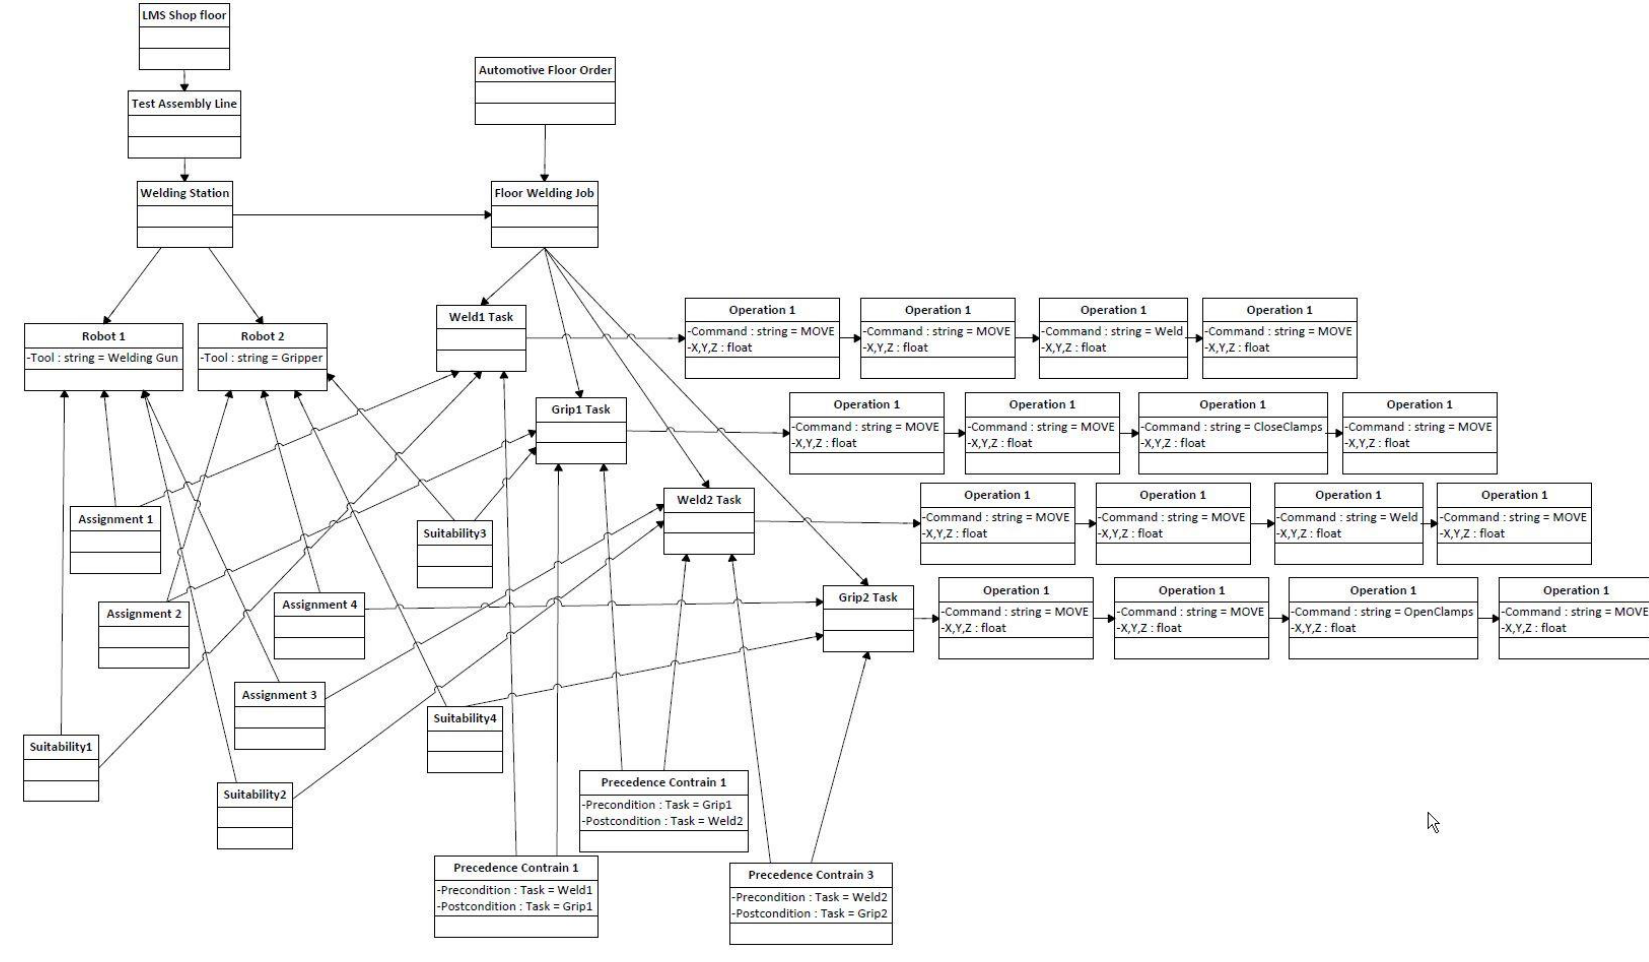
Figure 9. Use-case instantiation of the ontology model.